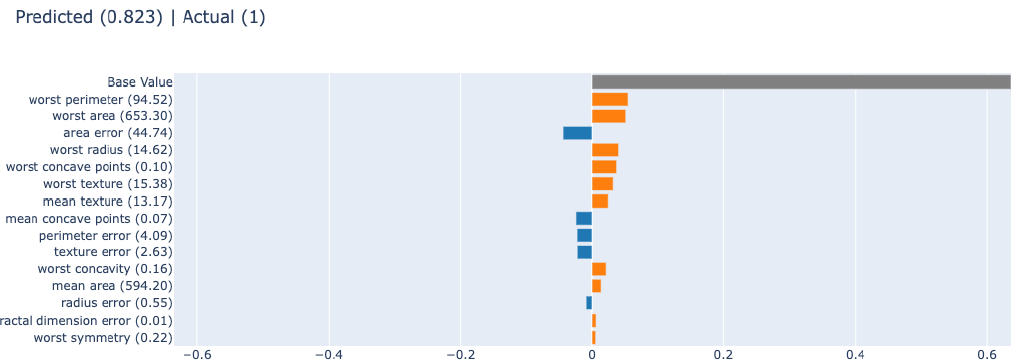
Figure 6. Interpreting a prediction with the post hoc XAI method: SHAP.